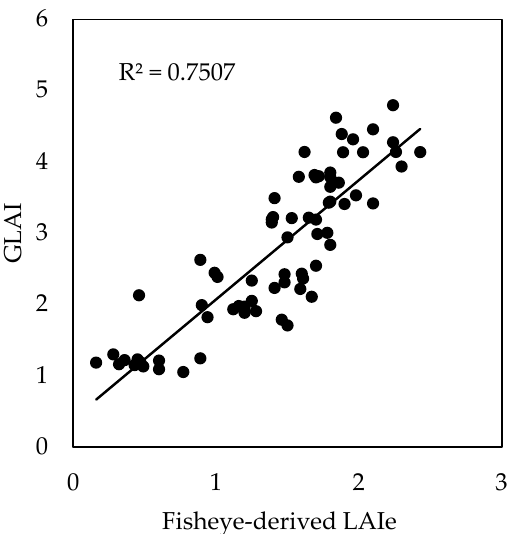
Figure 7. Relationship between the simulated GLAI and fisheye derived LAIe for 12 sampling locations in S1.